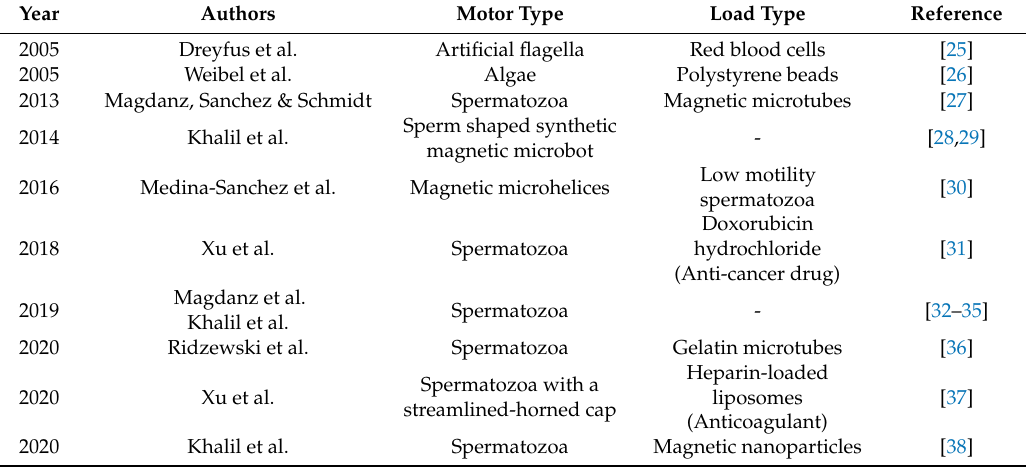
Table 1. Timeline for biohybrid sperm development detailing the motor type used and the load carried, if any (Further details can be found in schematic time line in Figure